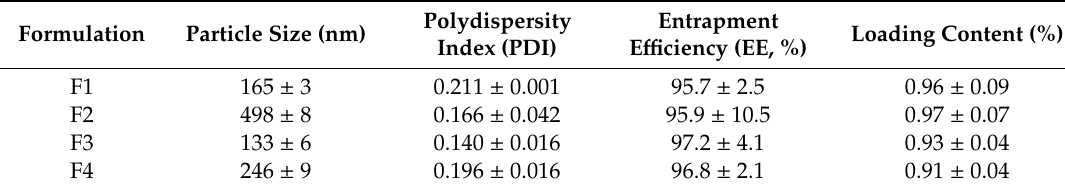
Table 3. Physicochemical properties of the orobol-loaded NLCs and